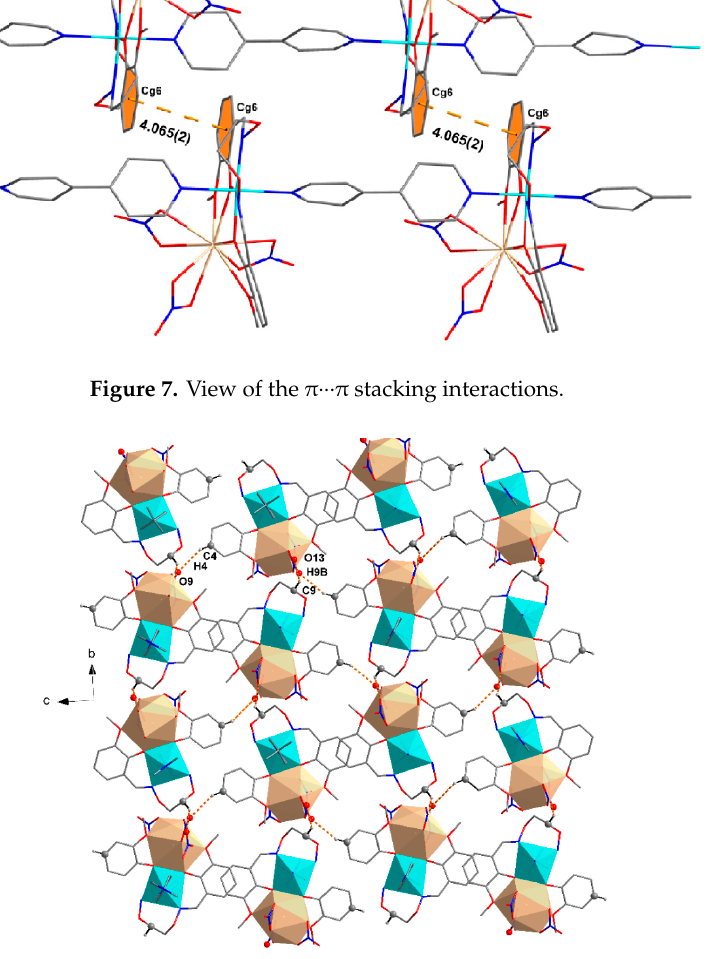
Figure 8. View of two-dimensional supramolecular network of the title polymer, combined by intermolecular hydrogen bondings.